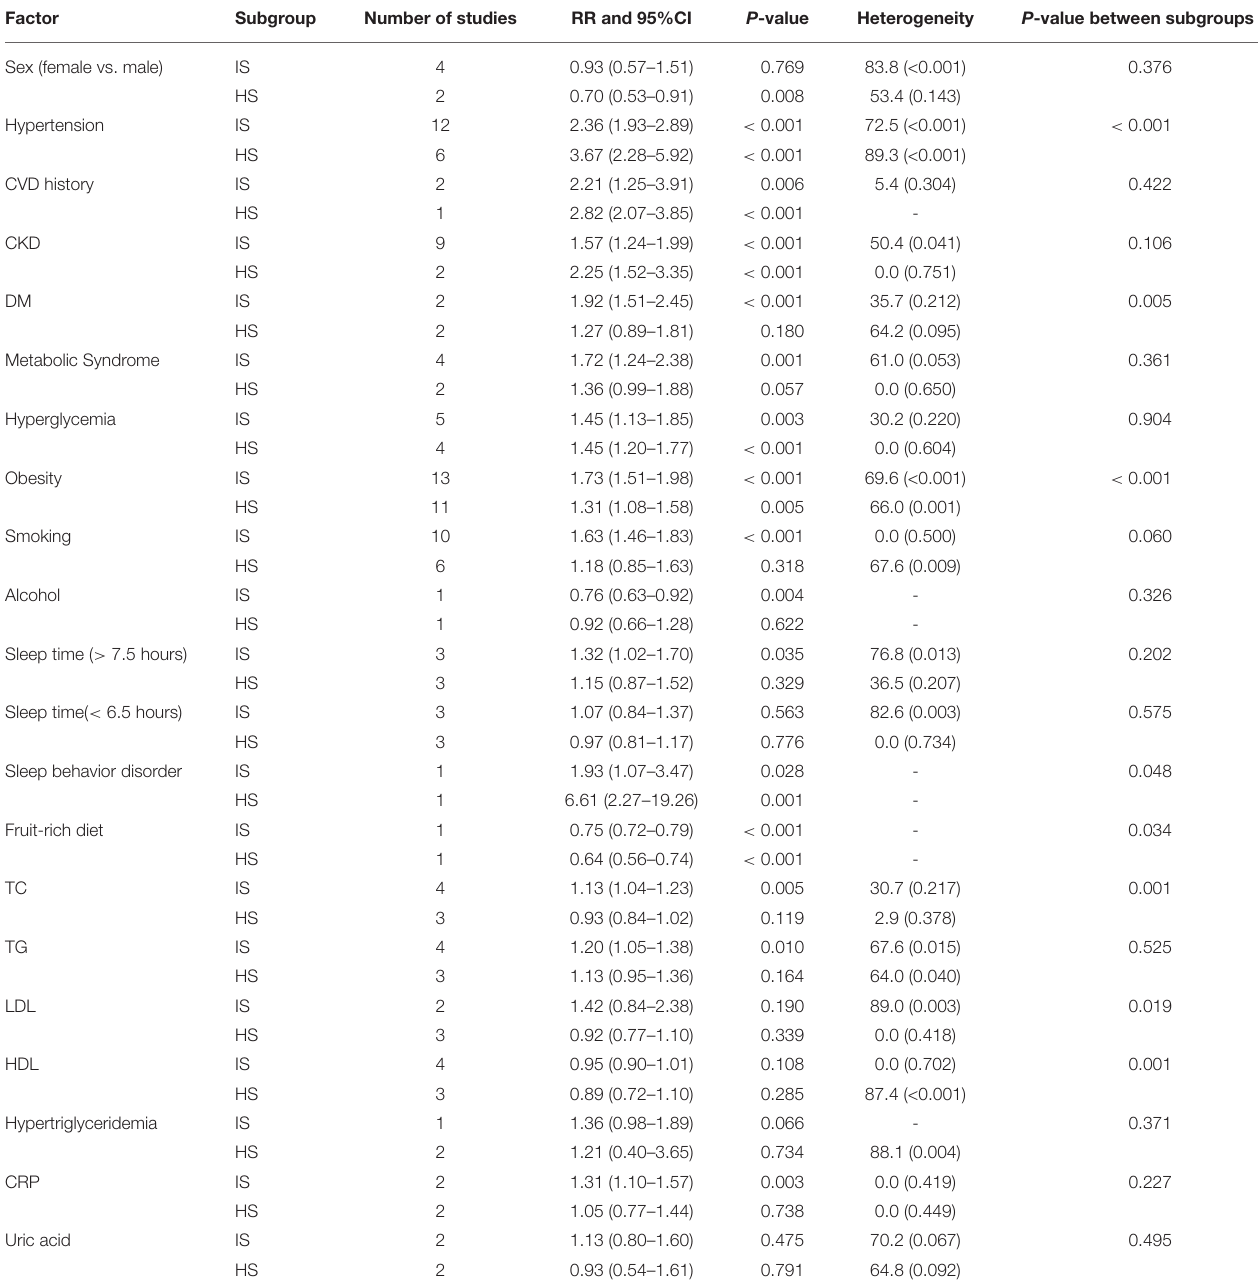
TABLE 2 | Subgroup analysis of stroke